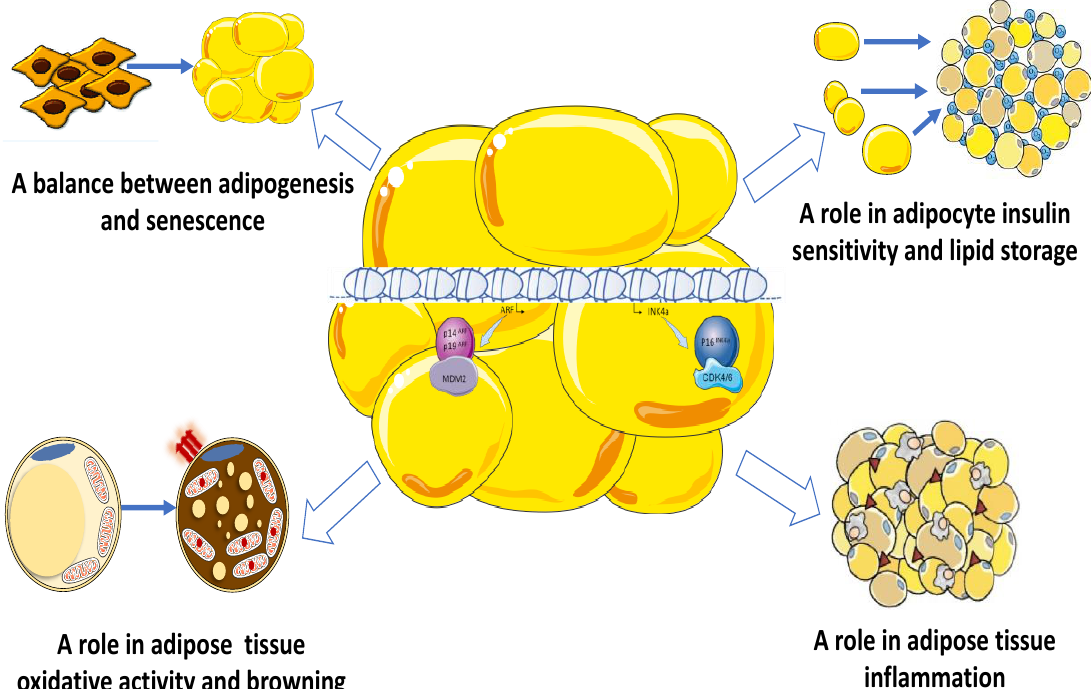
Figure 2. The INK4a / ARF locus as a key regulatory hub to maintain adipose tissue in a healthy state. The INK4A / ARF locus regulates the balance between adipogenesis and senescence and promotes lipid storage as triglycerides and adipocyte hypertrophy via the insulin-signaling pathway. It has been described as a molecular switch of white-to-beige adipocyte conversion and as a key determinant of brown adipocyte fate, being an alternative way to increase energy expenditure. It is also involved in the switch between macrophage phenotype and thus obesity-related inflammation.